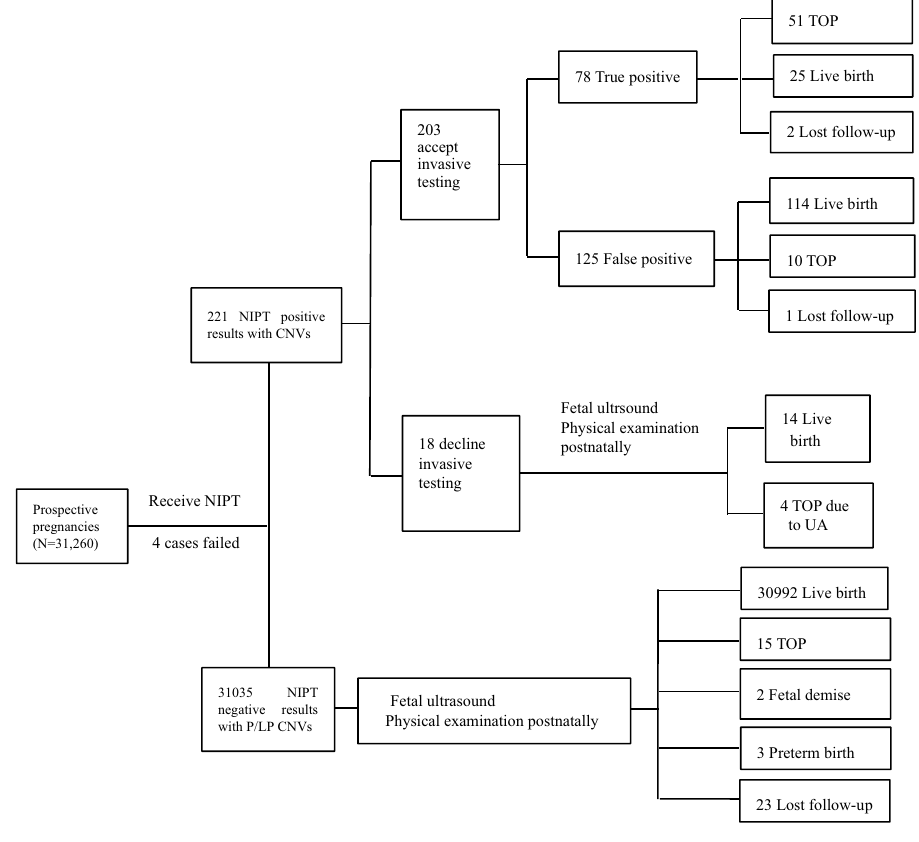
Figure 1. Flowchart of NIPT-Plus results and clinical outcome of pregnant women. NIPT noninvasive prenatal testing, TOP terminate of pregnancy, UA ultrasound anomaly. *CMA detection of induced labor tissue indicated true